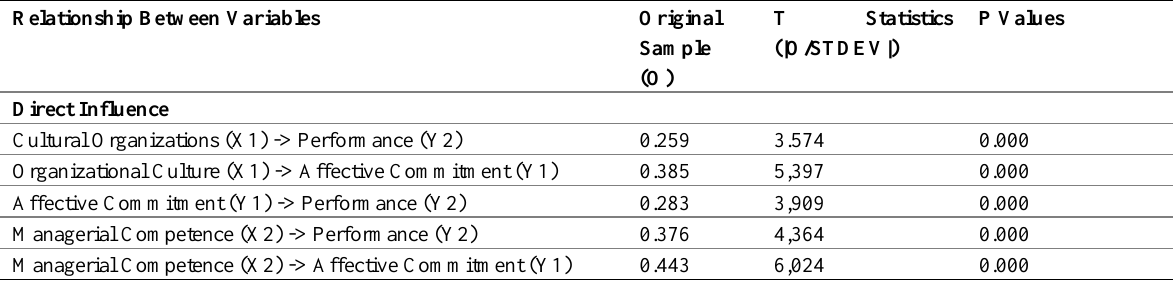
Table 20: Estimated Path Coefficients and T-Statistics Total